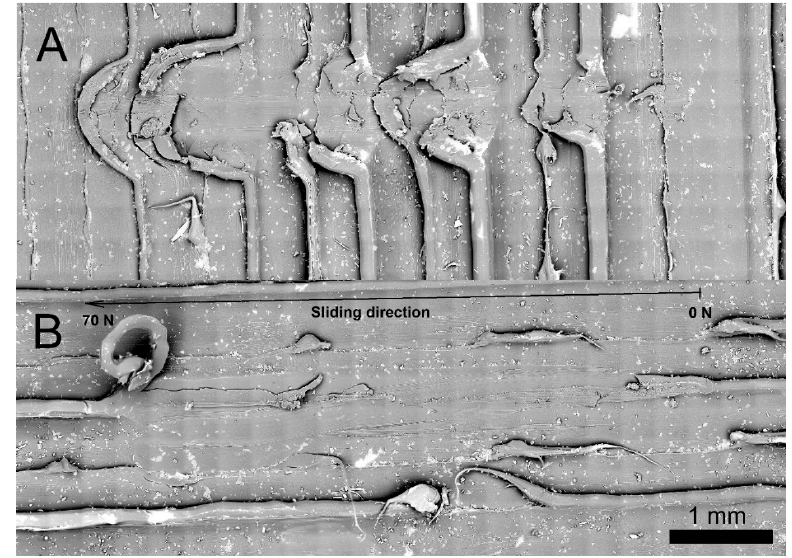
Figure 16. Micro scratch test: ( A ) perpendicular to the printing direction; ( B ) parallel to the printing direction.